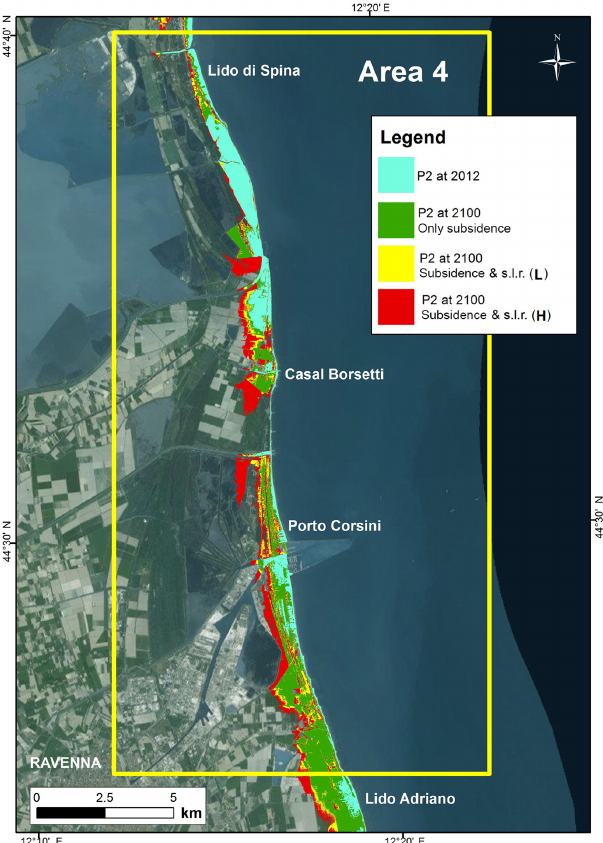
Figure 10. The same as in Fig. 6, but for Area